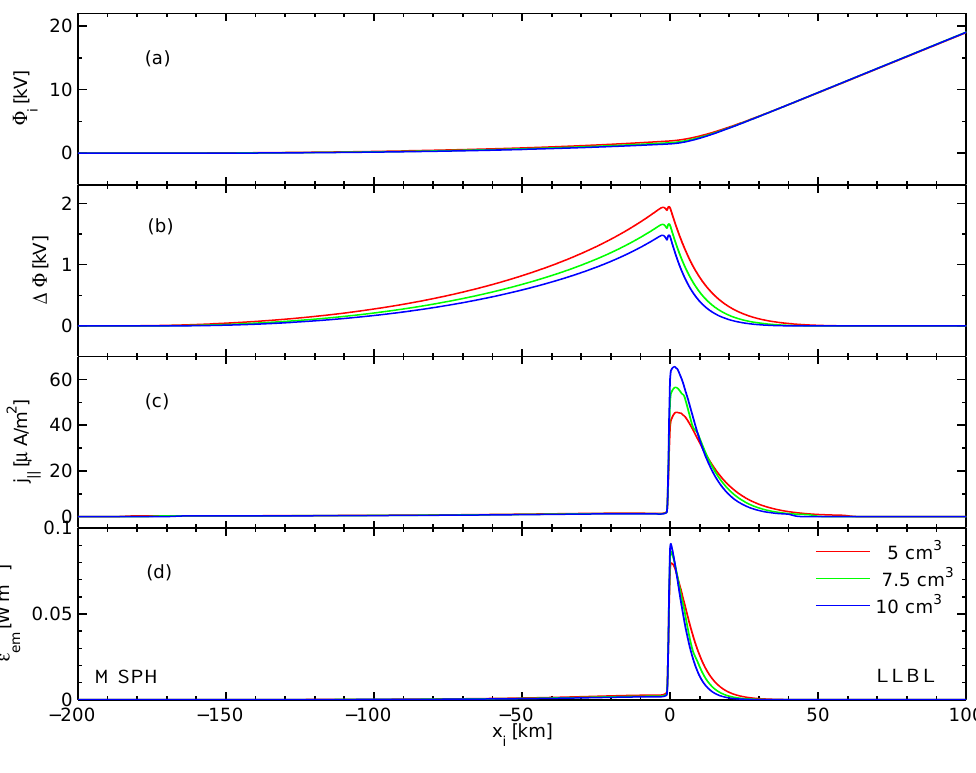
Fig. 6. Solution of Eq. (1) and derived quantities obtained for various densities at the LLBL side of the TD. See caption of Fig. 4. Magneto- spheric and ionospheric parameters used to derive these solutions are given in Tables 1 and 2.